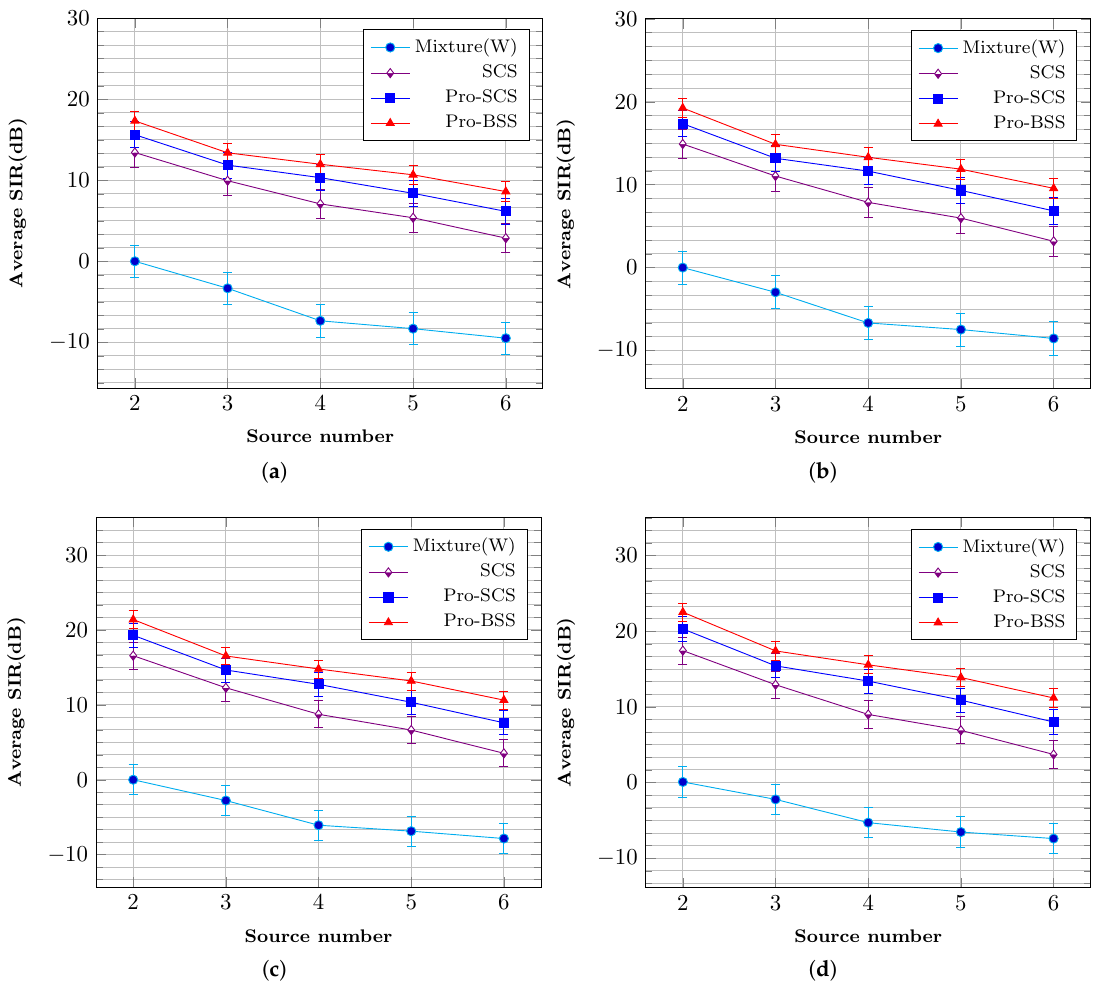
Figure 12. SIR results. Error bars represent 95% confidence intervals, ( a – d ) represent the results for separations {30 ◦ , 40 ◦ , 50 ◦ , 60 ◦ }, SNR = 20 dB, RT 60 = 0.5 s.